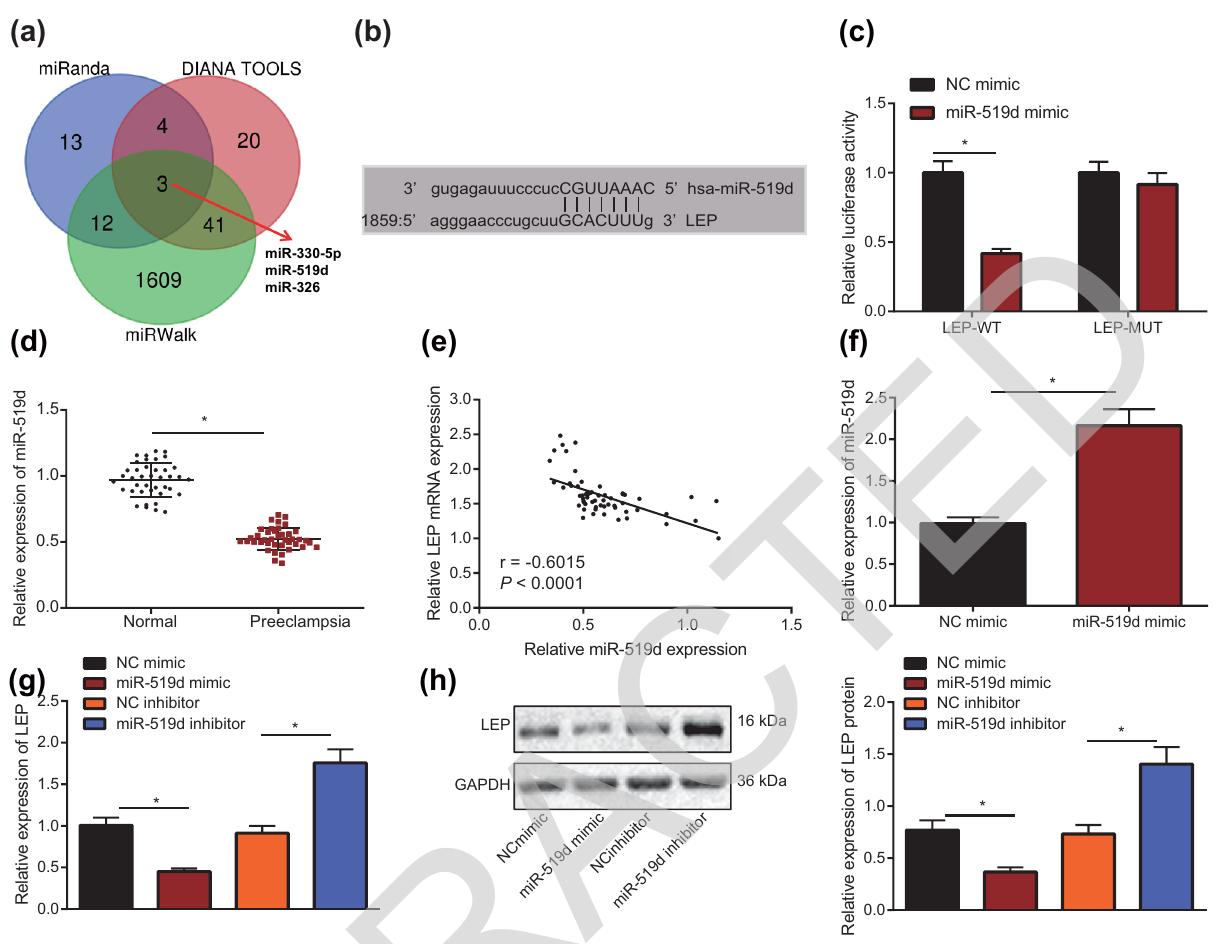
0.00.51.01.52.02.5 Figure 3: LEP is the downstream target gene of miR - 519d. ( a ) Venn Diagram of miRNA binding to LEP gene predicted by Miranda, mirwalk, and Diana tools. ( b ) The miRanda website was used to predict the miR - 519d and LEP target binding site. ( c ) Dual - luciferase reporter gene assay was used to con fi rm the miR - 519d and LEP binding site. ( d ) The levels of miR - 519d in normal pregnancy tissue and PE placenta tissue were tested using RT - qPCR ( Normal = 40; PE = 40 ) . ( e ) The correlation between miR - 519d and LEP expression in normal pregnancy tissue and PE placenta tissue was analyzed by Pearson correlation analysis. ( f ) miR - 519d gene overexpression in HTR - 8/SVneo cells was detected by RT - qPCR. ( g ) When miR - 519d was overexpressed or silenced, the level of LEP in HTR - 8/SVneo cells was detected with RT - qPCR. ( h ) When miR - 519d was overexpressed or silenced, the expression of LEP protein in HTR - 8/SVneo cells was detected by Western blot; * indicates P < 0.05 ( the measurement data were shown as the mean ± standard deviation, and two independent samples t - test were used in comparison; Unpaired t - test was used for two sets of data statistics result comparison; Single factor analysis of variance was used for multigroup data comparison; The correlation between miR - 519d and LEP was evaluated with Pearson correlation and the tests were conducted in triplicate ) detected by CCK - 8 assay ( Figure 5c ) , cloning ability was signi fi cantly attenuated the inhibitory e ff ect of LEP over - measured by clone formation assay ( Figure 5d ) , and cell expression on cell proliferation ( P < 0.05 ) . The scratch cycle was determined by fl ow cytometry ( Figure 5e ) . As test was used to measure the migration ability of HTR - shown in fi gure, the cell viability and cloning ability 8/SVneo cells and their invasion was detected by the in miR - 519d mimic + oe - NC group were signi fi cantly Transwell test. The results ( Figure 5f and g ) indicated increased than NC mimic + oe - NC group, HTR - 8/SVneo that the cell migratory ability and invasive capacity were cells in G0/G1 phase were signi fi cantly reduced, and cells signi fi cantly greater in the miR - 519d mimic + oe - NC in S phase increased signi fi cantly ( P < 0.05 ) . The cell group than in NC mimic + oe - NC group, but were signi fi - cantly reduced in the NC mimic + oe - LEP group. It can be viability and cloning ability in the NC mimic + oe - LEP seen that miR - 519d mimic reversed the inhibitory e ff ect of group were signi fi cantly inhibited, with more HTR - 8/ overexpression of LEP on the migratory ability and inva - SVneo cells in G0/G1 phase, and fewer cells in S phase ( P < 0.05 ) , and it can be seen that miR - 519d mimic sive capacity of HTR - 8/SVneo cells ( P < 0.05 ) . Finally, the